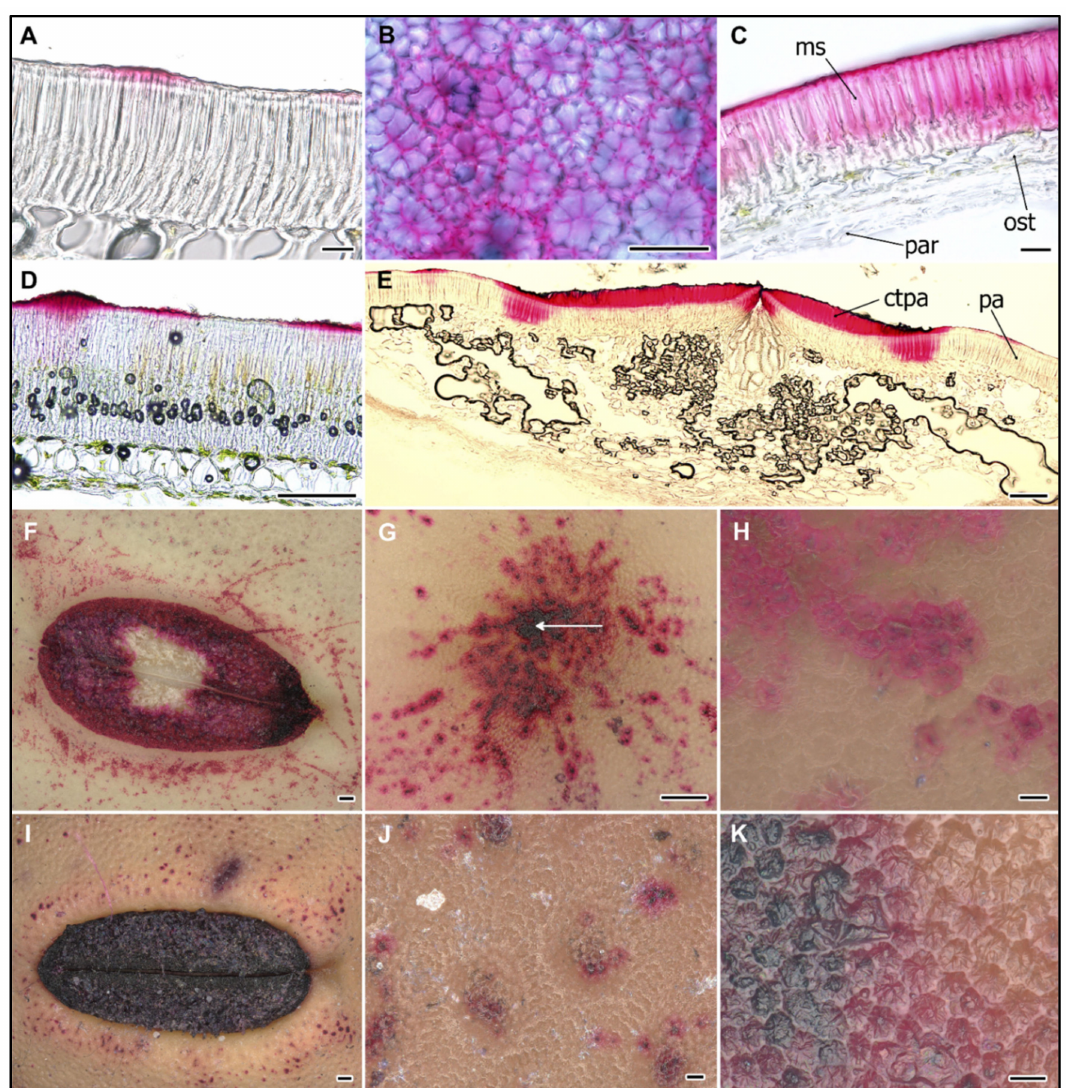
Figure 5. Histochemical Ruthenium Red staining of pectin substances. Mature dry seed staining of cultivated pea ( Pisum sativum subsp. sativum ): cv. Cameor ( A – C ), paradermal section ( B ), 24 h imbibed seed ( C ); wild pea ( Pisum sativum subsp. elatius ): JI64 ( D , E ), hilum region ( E ). Surface of cv. Cameor ( F – H ), hilum ( F ), micropyle, arrow ( G ); JI64 ( I – K ). Scale bars = 20 µ m ( A – C ), 100 µ m ( D – G , I ) and 10 µ m ( H , J , K ). Abbreviations: ms—macrosclereid cells,